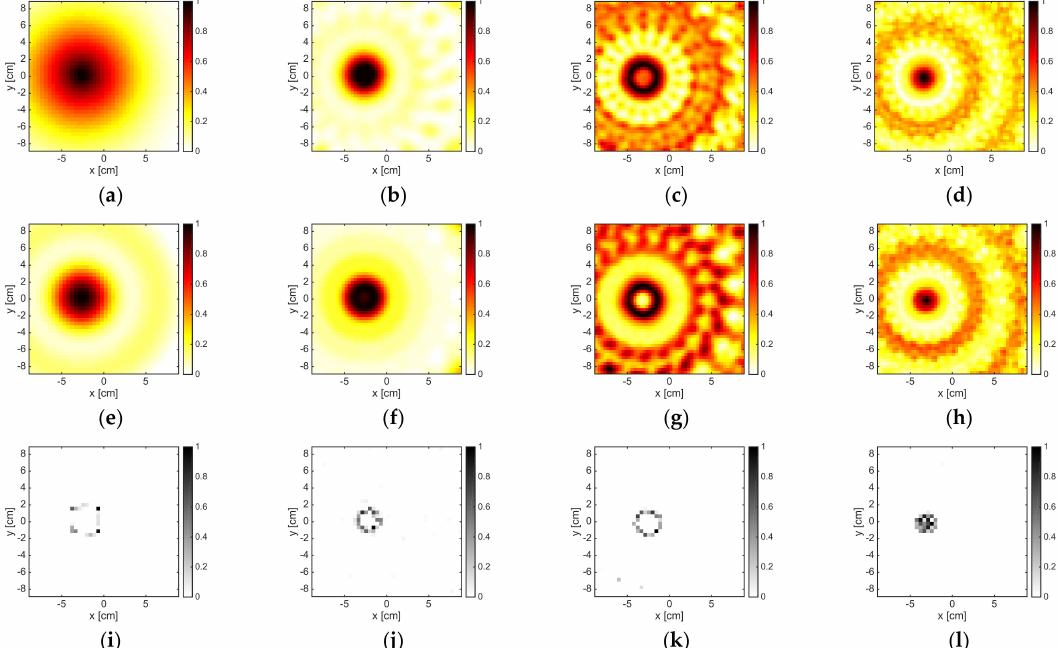
Figure 3. The DielTM target. From left to right: 2 GHz, 6 GHz, 12 GHz, and 16 GHz. From top to bottom: LSM, OSM, and B-IS indicators. The number of measurements and views was M =